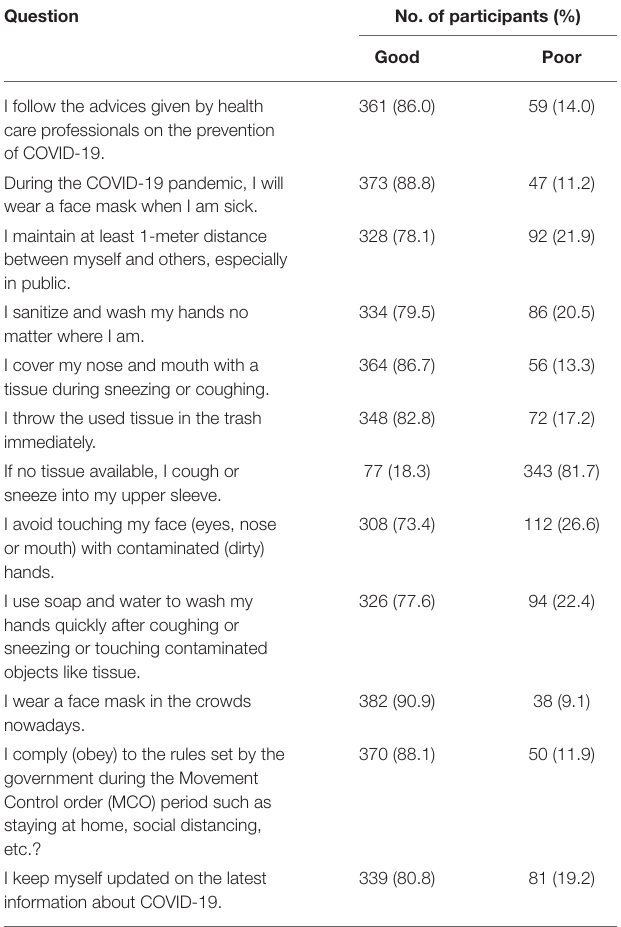
TABLE 4 | Response of study participants for COVID-19 preventive practice questions.